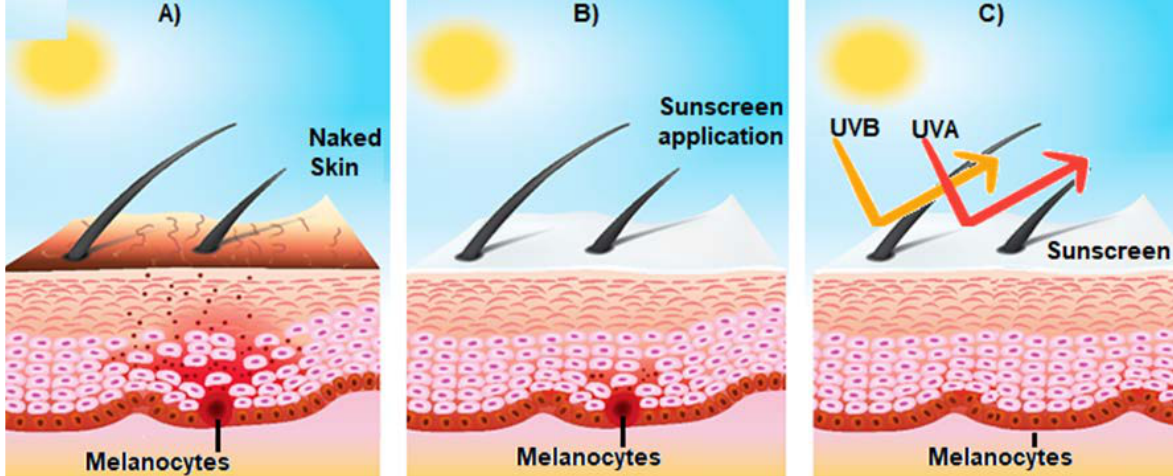
Figure 3. Effect of sunscreen on the prevention of sun-induced damage. ( A ) Shows the activation of epidermal melanocytes by sun UV radiation and the consequent release of melanin (brown spots) towards the surface of the skin, giving it a brown tone; ( B ) represents the consequences of the use of sunscreen on skin structure; and ( C ) broad spectrum sunscreen prevents the damage of the skin induced by UVA and UVB radiation.